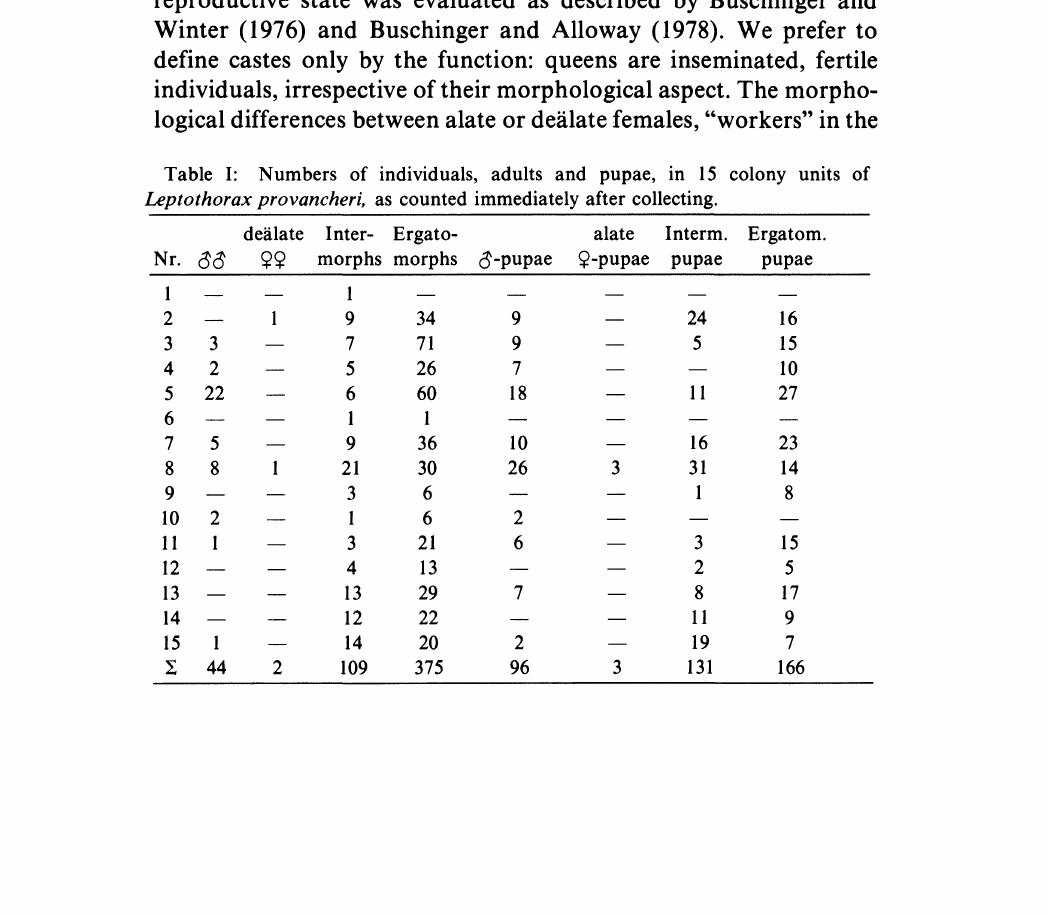
Table I: Numbers of individuals, adults and pupae, in 15 colony units of Leptothorax provancherL as counted immediately after collecting. depilate Inter- Ergato- alate Interm. Ergatom.